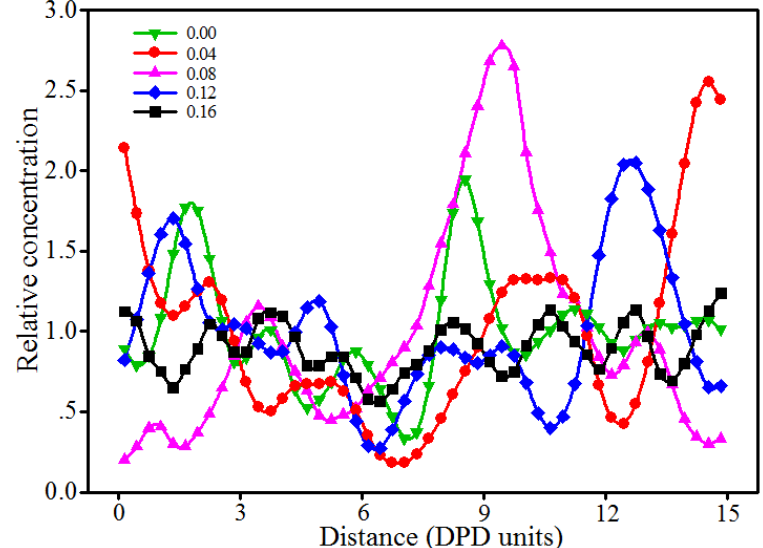
Figure 15. Relative concentration distribution functions of nano-silica in 10% PVA/10% PAM/1.5% nano-silica blended hydrogels under different shear rates.